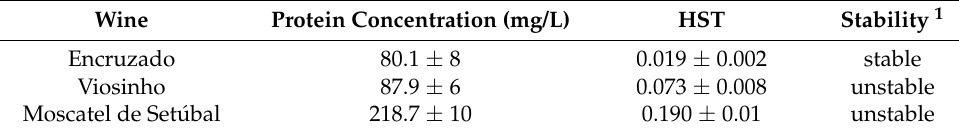
Table 1. Results of the protein concentration and protein stability tests